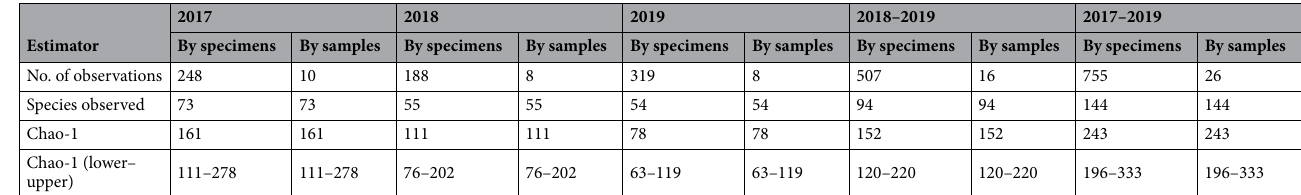
Table 1. Estimates of total species richness of the tachinid community by specimens and samples for 2017, 2018, 2019, 2018–2019 and 2017–2019, based on 1,000